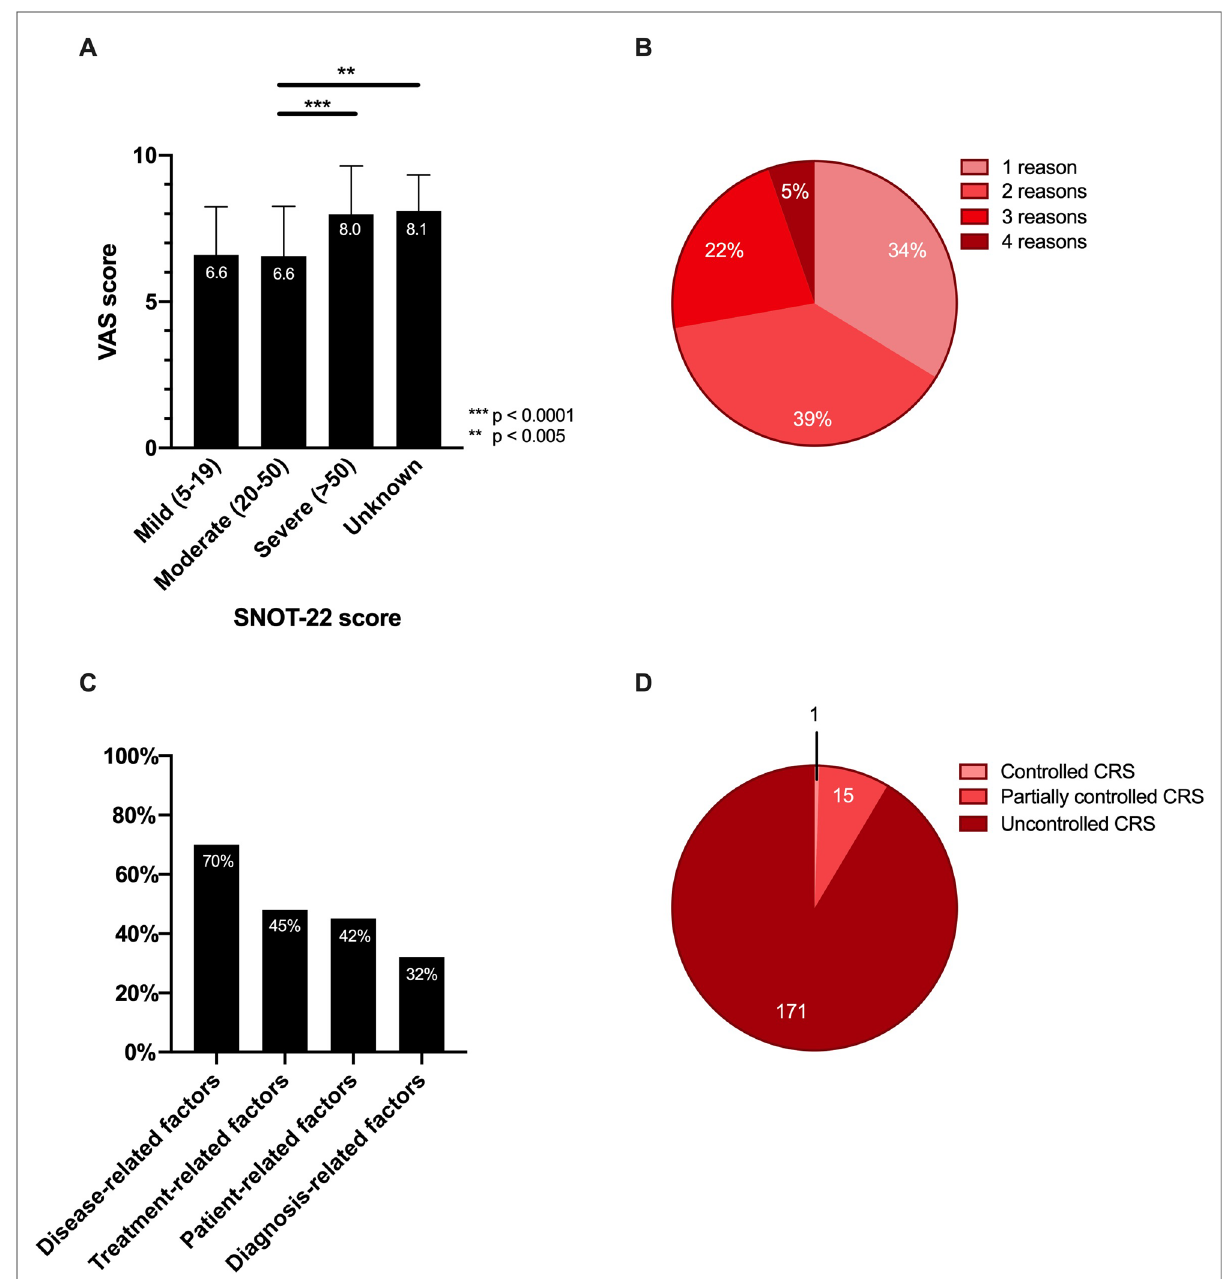
FIGURE 2 Average VAS score, number, and percentage of reasons for uncontrolled disease ( A ) average VAS score of patients in each SNOT-22 score group. Data are shown as mean±standard deviation. Kruskal-Wallis test was used for comparison between the different groups; *** p <0.0001; ** p < 0.007 ( B ) Number of reasons for uncontrolled disease as assessed by an ear-nose-throat (ENT) specialists based on the questionnaire and clinical evaluation. ( C ) Observed prevalence of each factor contributing to uncontrolled disease. ( D ) Disease status according to the EPOS 2020 guidelines for CRS in the patient cohort. We analyzed our inclusion criteria for uncontrolled CRS disease against the corresponding, more recently published, EPOS guidelines for uncontrolled disease in CRS patients (Fokkens et al ., 2020). The numbers represent the number of patients falling into the corresponding EPOS guideline category for controlled, partially or uncontrolled